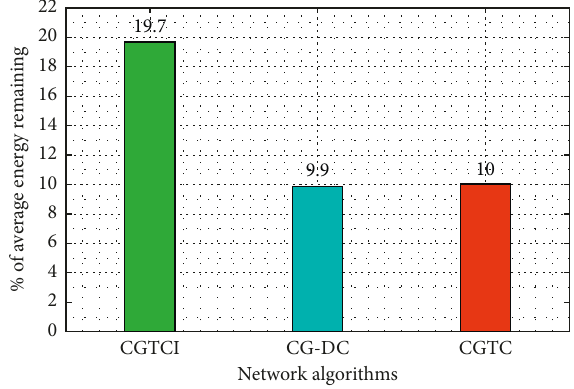
Figure 9: % of average remaining